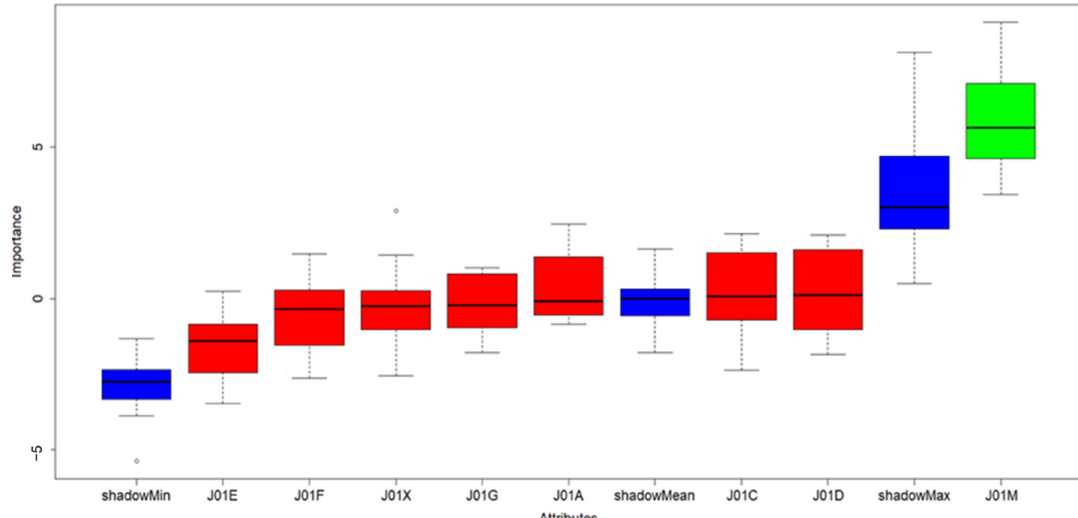
Figure 2. Results of Boruta algorithm; color legend: blue boxes: shadow features added by Boruta algorithm used for evaluation of significant and insignificant variables in scope. Green box: significant/important properties, Red boxes: in- significant/redundant properties in dataset.